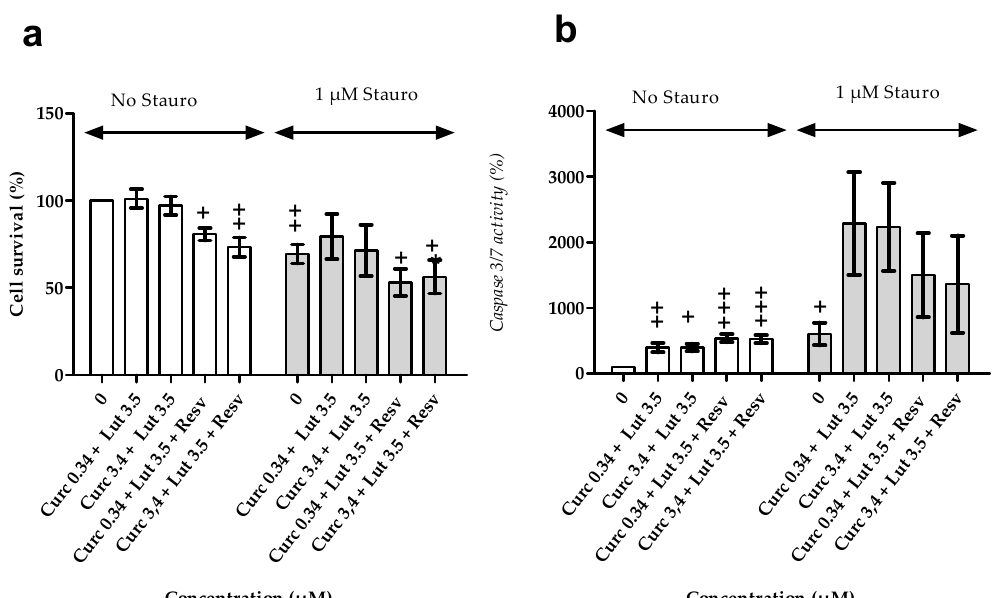
Figure 7. E ff ect of combination of natural agent on cell survival and caspase 3 / 7 activity. ARPE-19 cells were treated with curcumin + lutein or with curcumin + lutein + resveratrol for 24 h. Then, they were treated with staurosporin at 1 µ M for 18 h. ( a ) Cell survival assessment and ( b ) caspase 3 / 7 activity. Results are expressed as mean percentage ± SEM (n = 6 independent experiments, each tested in triplicate). Statistical significance ( + ) compared to no pre-treatment.